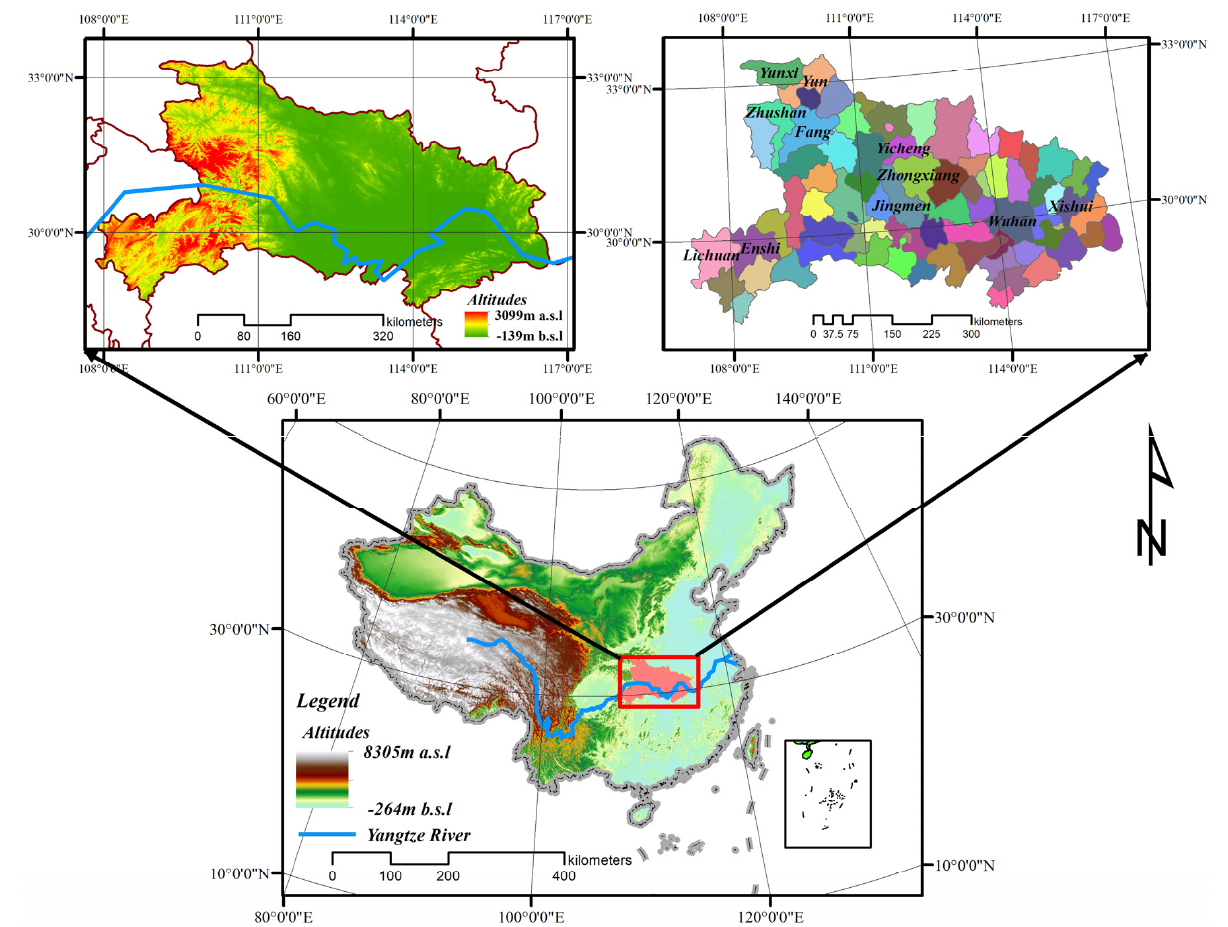
Figure 1. Location of Hubei, China. Note: Figure in top right shows the administrative area of Hubei Province. It consists of 77 administrative units, including 12 prefecture level cities, 1 Autonomous Prefecture, 26 county − level cities, 35 counties, 1 Autonomous County and 1 forest